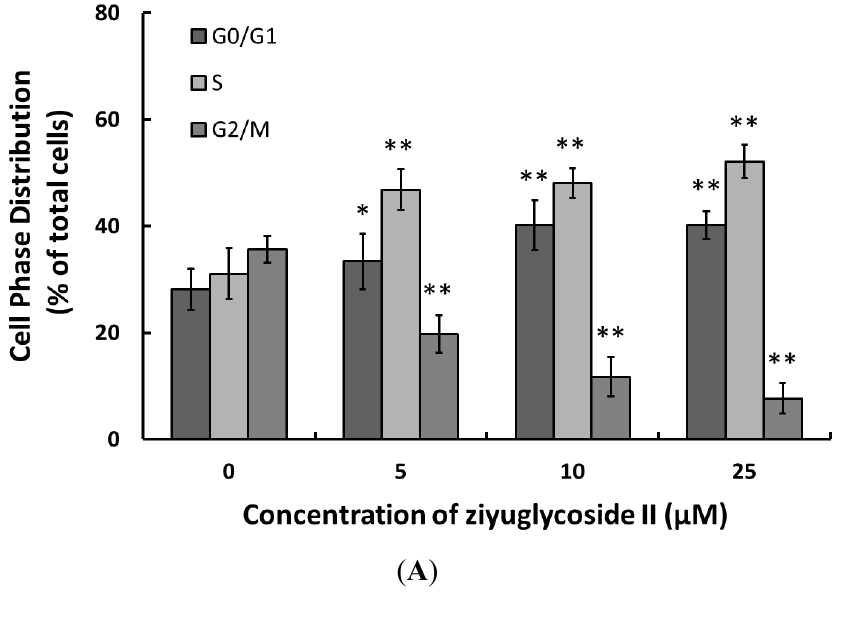
Figure 2. The effect of ziyuglycoside II on cell cycle distribution and apoptosis of MDA-MB-435 cells. Cells were incubated with various concentrations of ziyuglycoside II for 24 h, cell cycle distribution ( A ) and apoptosis ( B ) were assessed by flow cytometric analysis as described in Materials and Methods. All data were expressed as mean ± SD of three experiments and each experiment included triplicate repeats. * p < 0.05, ** p < 0.01 vs.